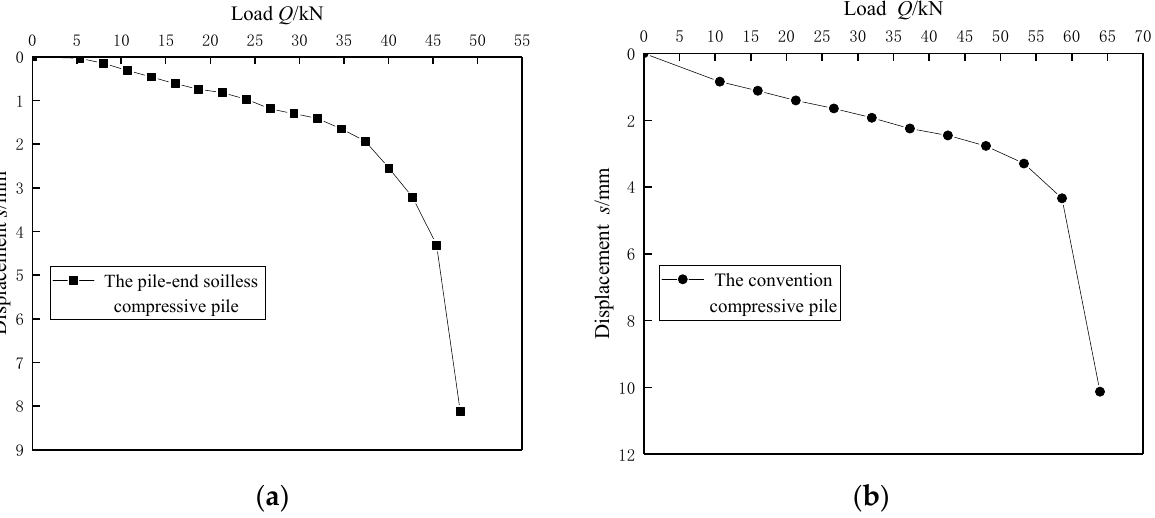
Figure 3. Schematic diagram of test pile loading: ( a ) the pile-end soilless compressive pile and ( b ) the conventional compressive pile.